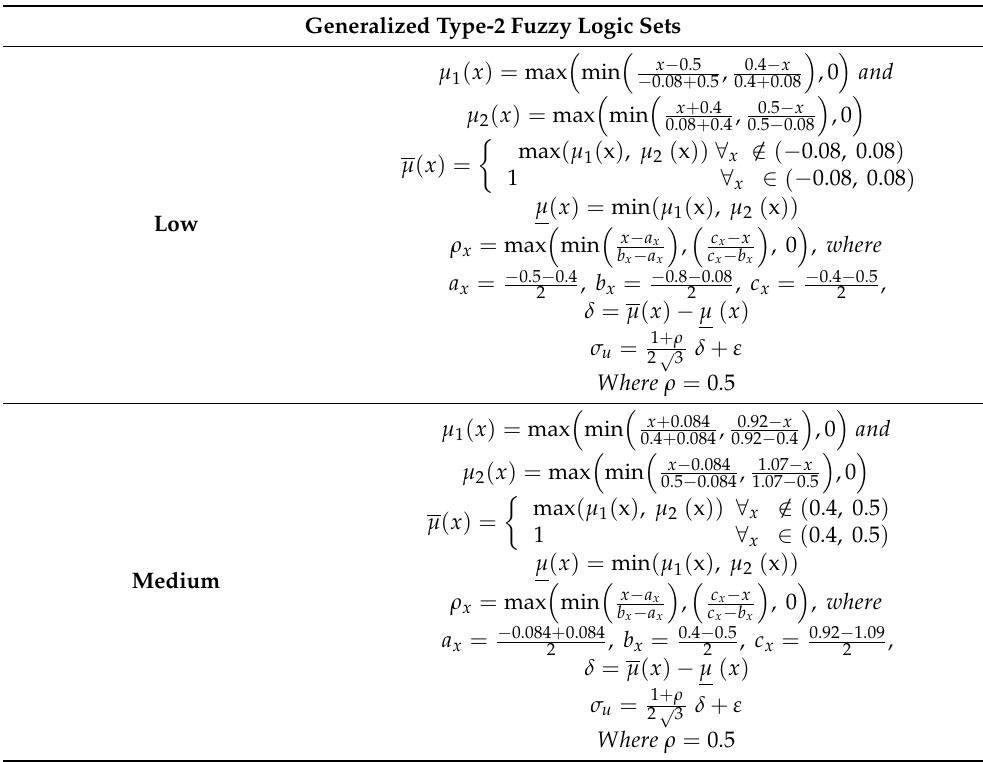
Figure 7. Structure of the General Type-2 fuzzy logic system. Table 2 shows the mathematical expression used by the GT2FDE fuzzy system. This table summarizes the parameterized knowledge of the fuzzy system. Table 2. Parameters of the General Type-2 fuzzy sets.